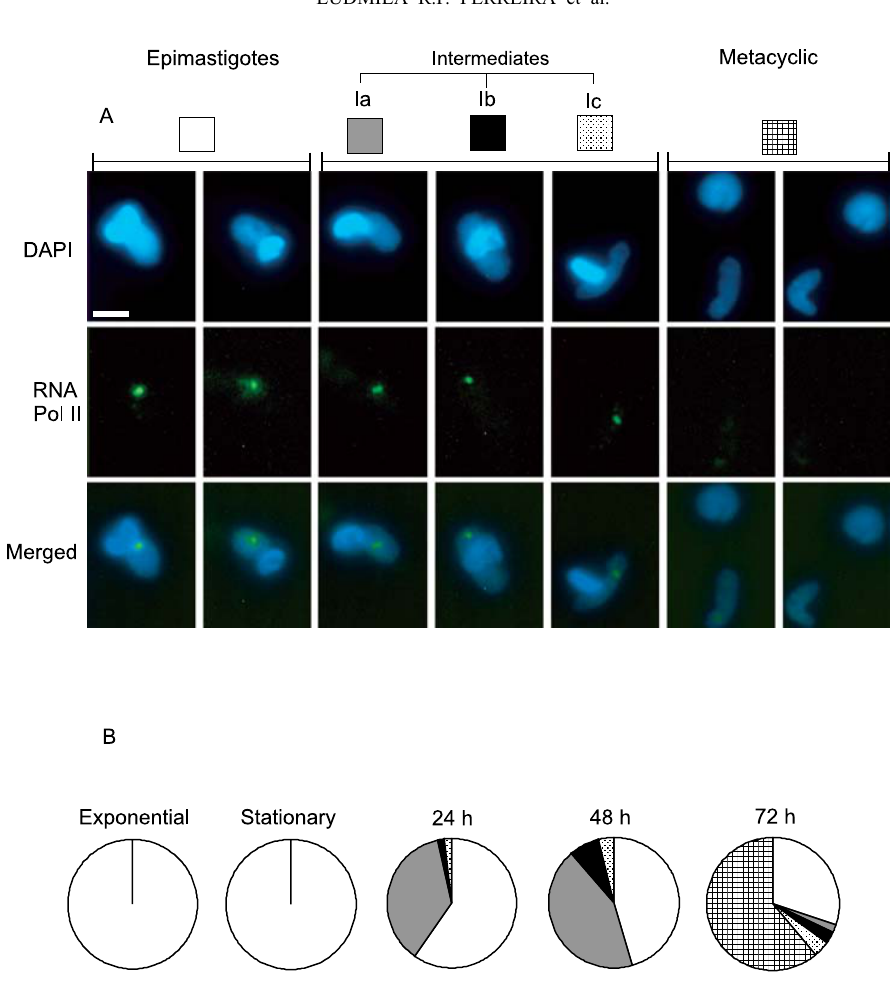
Fig. 2 – RNA Pol II labeling decreases only at the end of metacyclogenesis. A. Parasites at different times after metacyclogenesis were labeled with DAPI and by indirect immunofluorescence using antibodies against the T. cruzi RNA Pol II and DAPI (top and middle images). The bottom figures correspond to merged DAPI and immunofluorescence images. The figure show representative images of epimastigotes, intermediate stages and metacyclic-trypomastigotes. Panel B show the relative number of each parasite form as defined in panel A in exponentially growing cells, at the stationary phase, and 24 and 48 hours after the nutritional stress. The 72 hour graphic indicates the distribution found in the